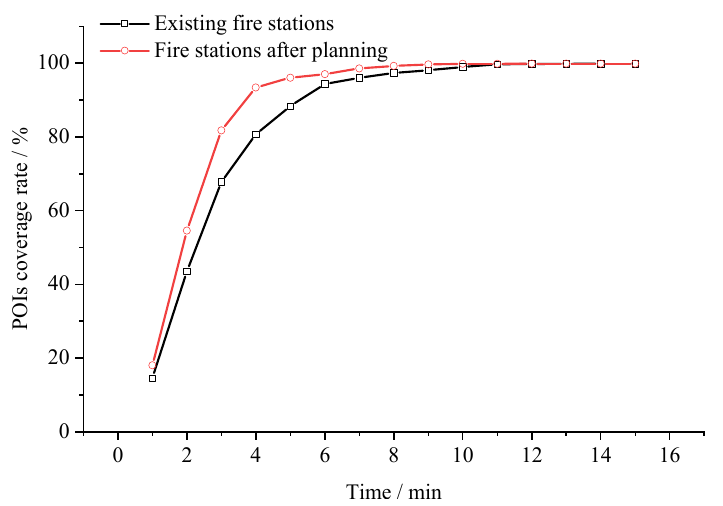
Figure 12. POI coverage rate of fire stations at different times before and after planning.